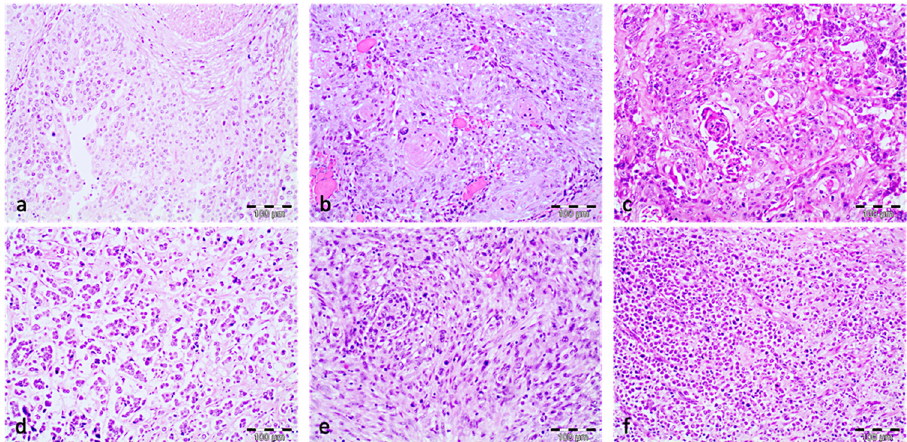
Figure 1. Histopathological findings of muscle-invasive urothelial cell carcinoma. ( a ) Urothelial cell carcinoma. ( b ) Urothelial cell carcinoma with divergent squamous differentiation. ( c ) Pure squamous cell carcinoma. ( d ) Micropapillary carcinoma. ( e ) Sarcomatoid carcinoma. ( f ) Plasmacytoid carcinoma. (HE, 10×).